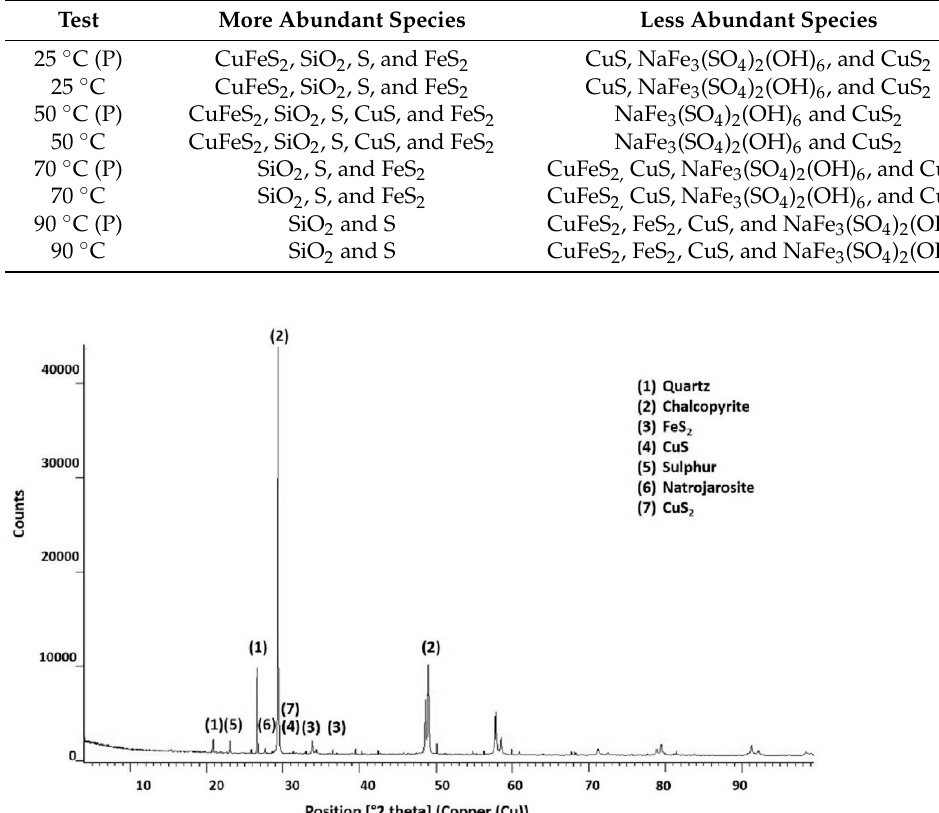
Figure 16. Species identified by X-ray diffraction in residues after chalcopyrite leaching at 25 °C without pretreatment.